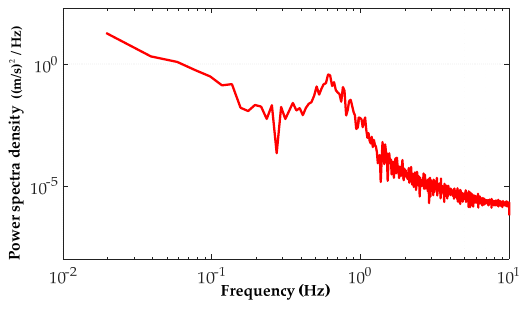
Figure 11. Power spectra density of wind speed.